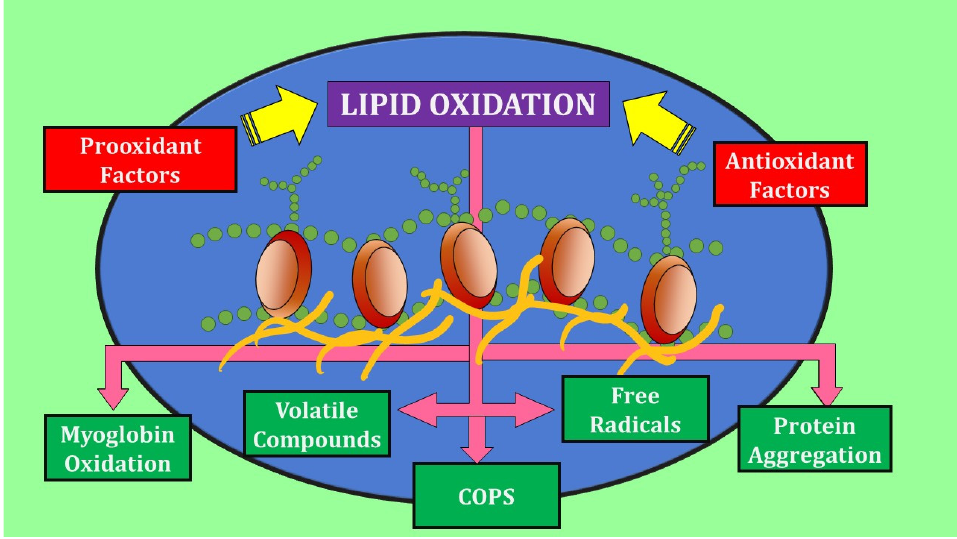
Figure 1. Schematization of lipid oxidation reactions in meat and the resulting changes.